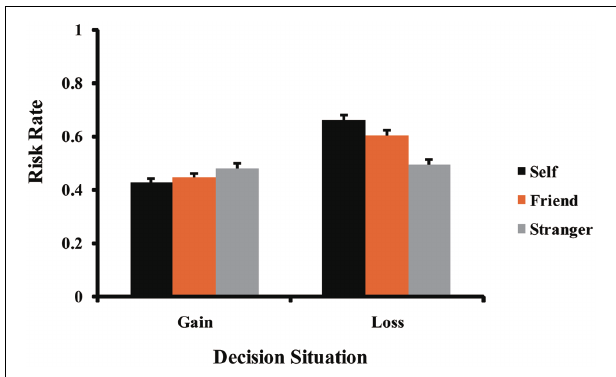
FIGURE 3 | Significant interaction of social distance × decision situation for the risk rate. Error bars indicate standard